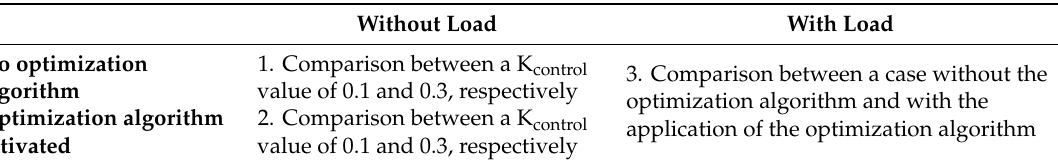
Table 2. Test cases studied for the orthosis control